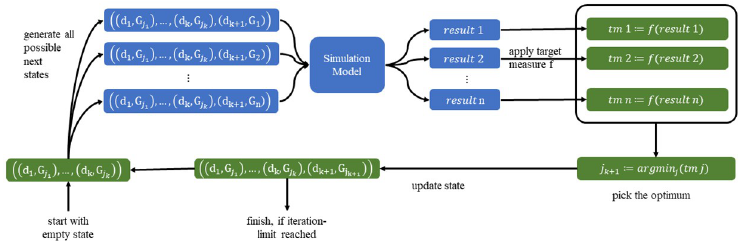
Fig 1. Iterative algorithm to optimize the distribution of the batches . The algorithm is started with an empty state and is terminated as soon as the sum of all state-exponents matches a predefined maximum iteration number.